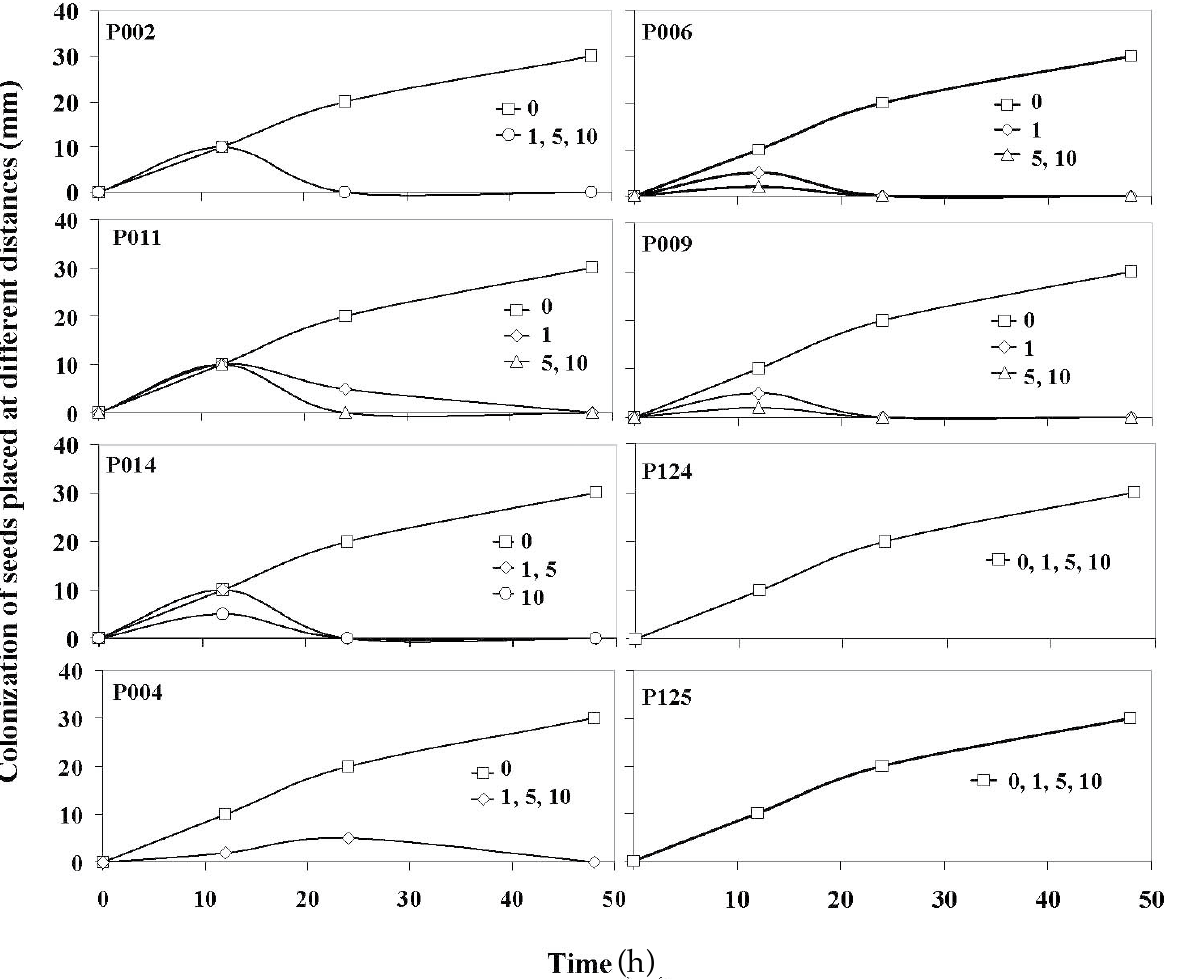
Figure 1. Influence of different concentrations of mefenoxam on the time required to colonize cucumber seeds by Pythium isolates differencing in sensitivity to mefenoxam (see Table 1 for characteristics of